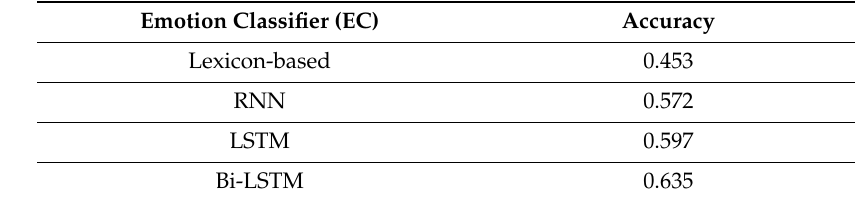
Table 2. Accuracy of emotion classifiers.